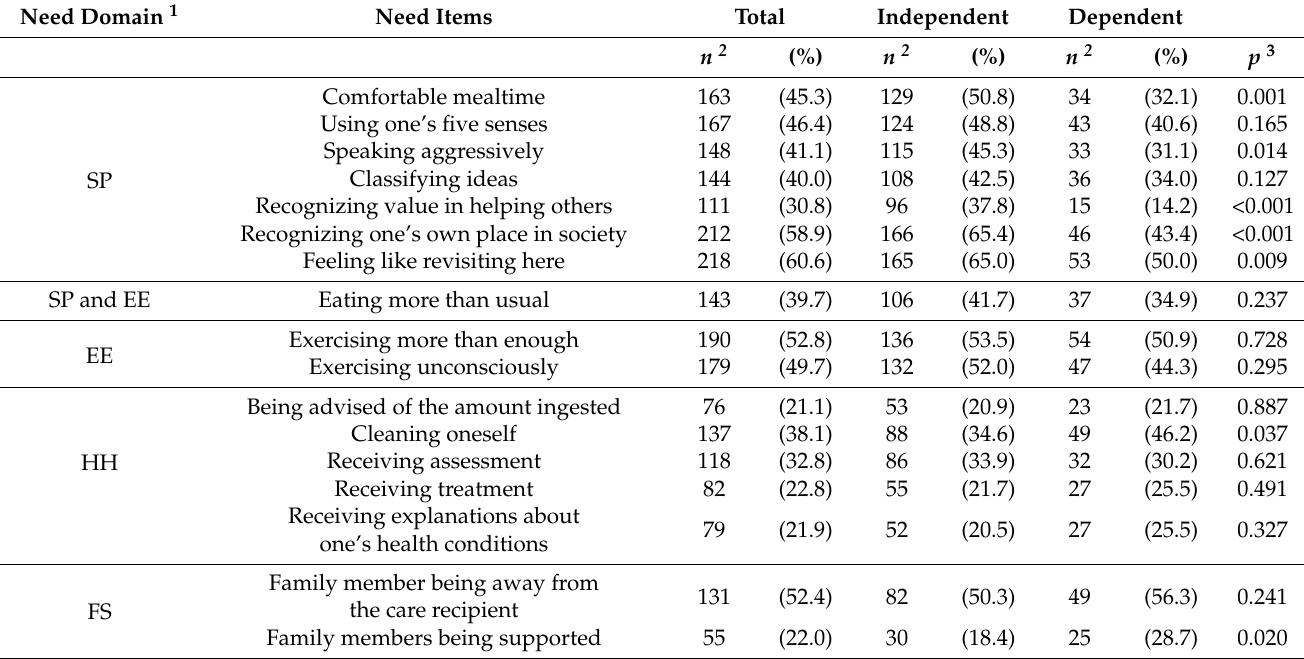
Table 2. Relationship between needs items in four domains and level of independence in standing up. Need Domain 1